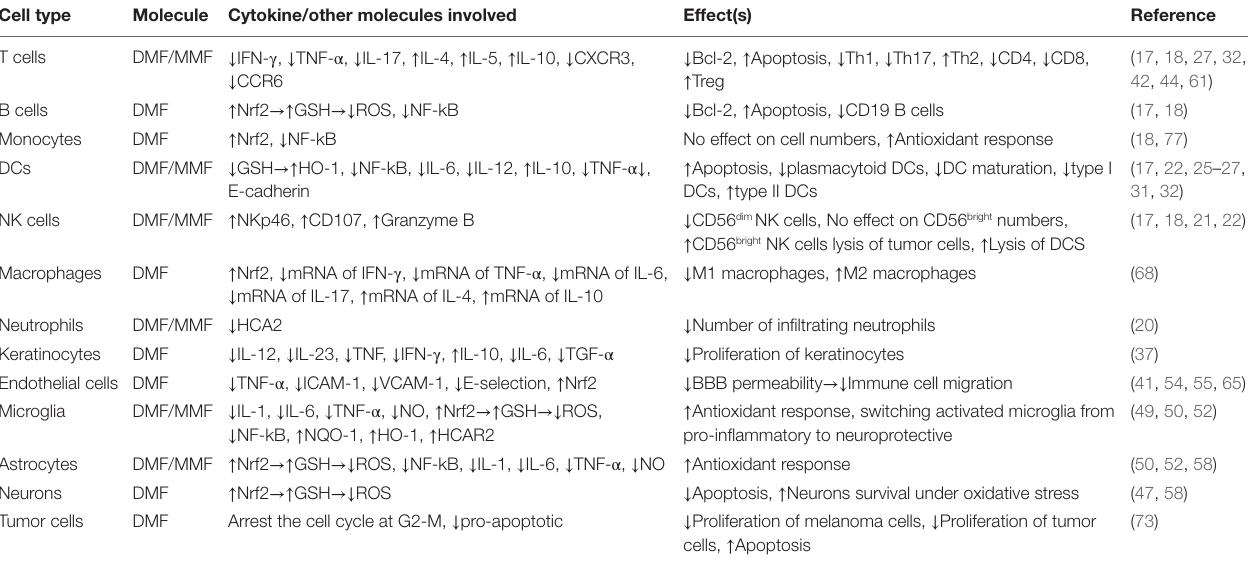
TABLe 1 | immunoregulatory effects of DMF and/or MMF on various immune cells. Cell type Molecule Cytokine/other molecules involved